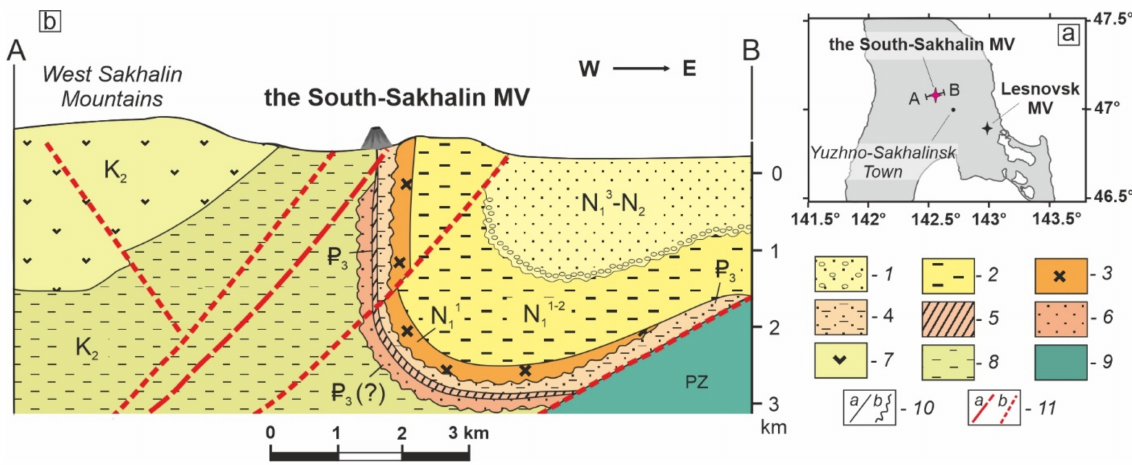
Figure 4. Cross-section of sediments beneath South Sakhalin MV, modified after [36]. ( a ) Sketch of southern Sakhalin Island. ( b ) cross-section along profile A–B. 1 = lignite-bearing conglomerate and sandstone (N 13 -N 2 ). 2 = siliceous siltstone and mudstone (N 11–2 ). 3 = dacitic andesite (N 11 ). 4 = sandy siltstone and mudstone ( ₽ 3 ). 5 = coal-bearing siltstone and mudstone ( ₽ 3). 6 = sandstone and conglomerate ( ₽ 3 (?)). 7 = volcaniclastic sediments (K 2 ). 8 = siltstone and mudstone (K 2 ). 9 = Paleozoic metamorphic rocks (PZ). 10 = concordant ( a ) and discordant ( b ) geological boundaries. 11 = man plane of the Tym-Poronay thrust ( a ) and other faults ( b ).